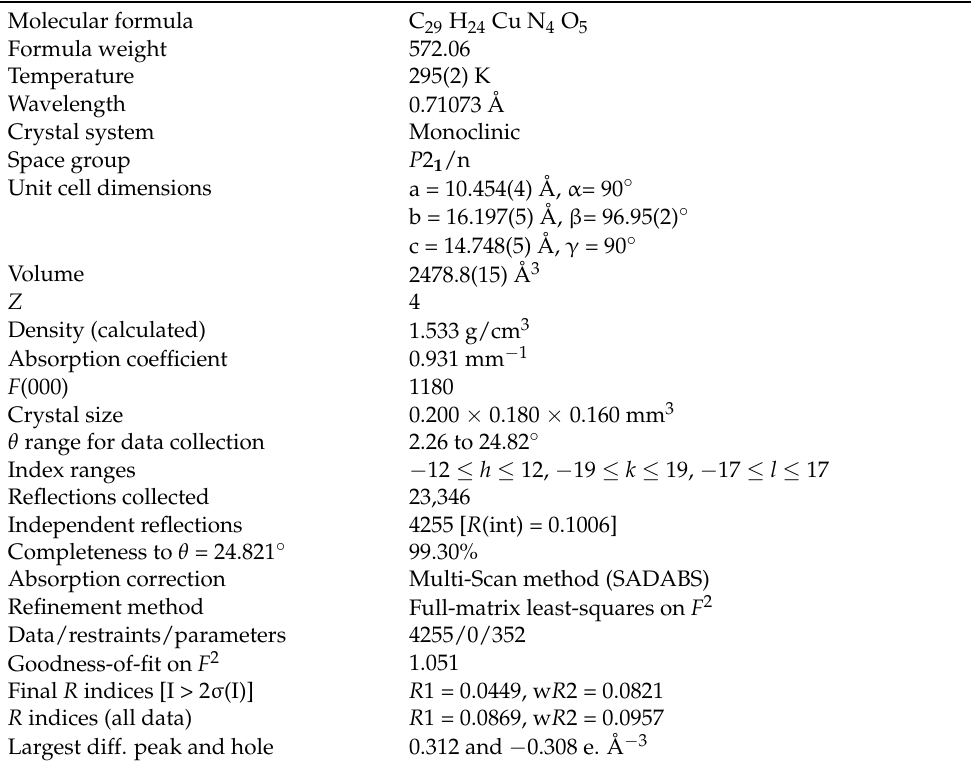
Table 1. Crystal data and structure refinement for [Cu(phen)(L)(NO 3